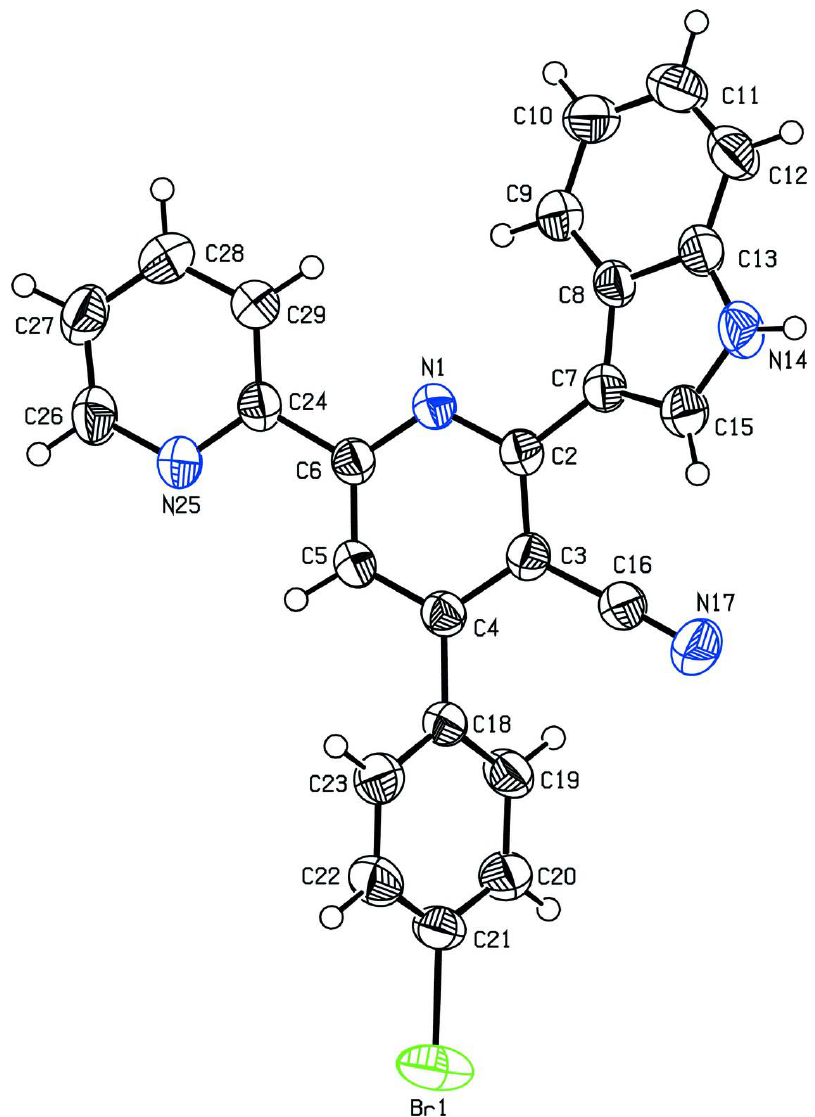
Perspective view of the molecule showing the displacement ellipsoids at 50% probability level. The H atoms are shown as small circles of arbitrary